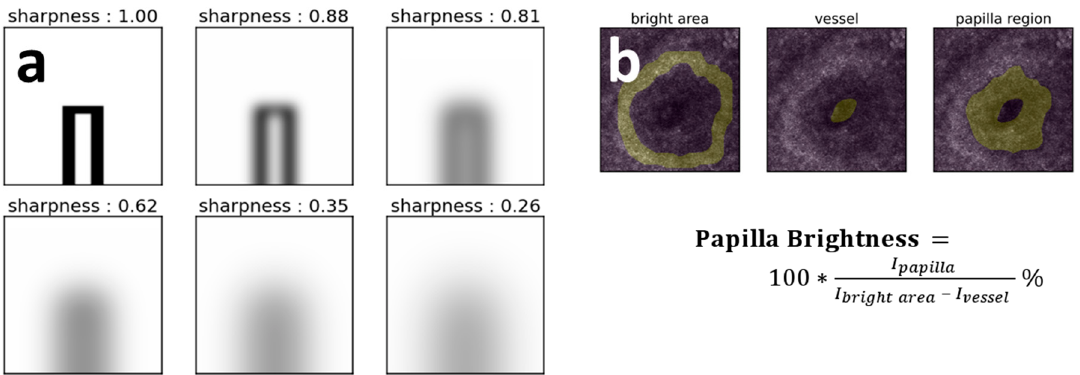
Figure 1. ( a ) Simulated images of microcapillaries blurred with a Gaussian filter with various σ parameter values and estimated sharpness. Gaussian filter values σ were equal to 0.5, 3.8, 7.2, 11, 14, and 17 (left to right, top to bottom). ( b ) Representative image of segmentation masks used to estimate papilla brightness in CLSM skin images.